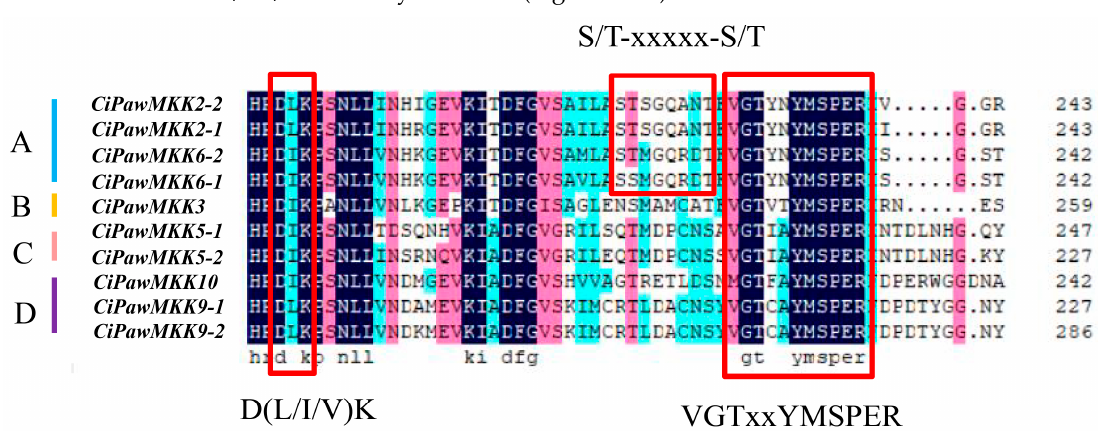
Figure 2. Multiple sequence alignment of MKK gene of pecan. The D(L/I/V)K and VGTxxYMSPER motifs specific to MKK genes and the S/T-xxxxx-S/T motifs contained in all group A genes are circled in red.